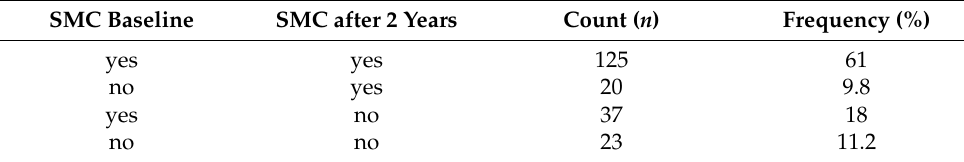
Table 2. Comparison of SMC prevalence at the baseline and after 2 years.